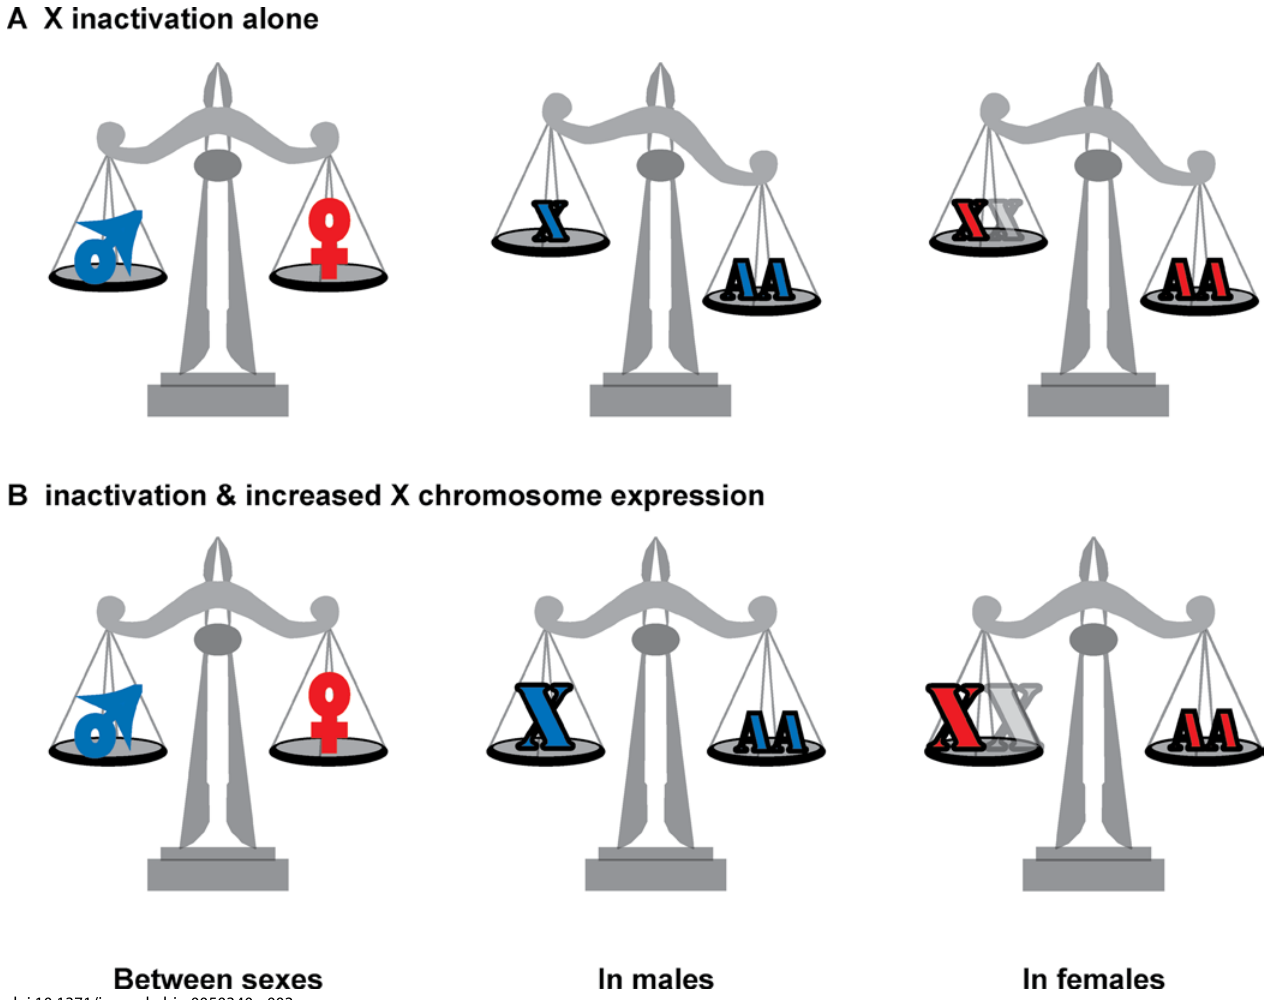
Figure 2. Balancing Expression (A) With X inactivation alone, female and male gene expression is equilibrated, but X and autosome (AA) expression in both males (blue) and females (red) is not. (B) X inactivation along with increased expression from the active X chromosome balances between the sexes and between X and